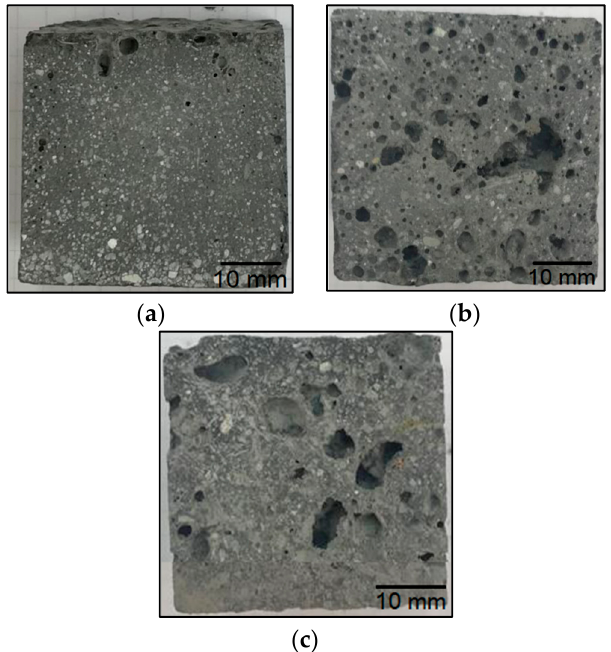
Figure 12. Breakthroughs of geopolymer samples based on fly ash and river sand with the addition of fraction I from a windmill turbine: ( a ) 5% fraction addition; ( b ) 15% fraction addition; ( c ) 30% fraction addition.